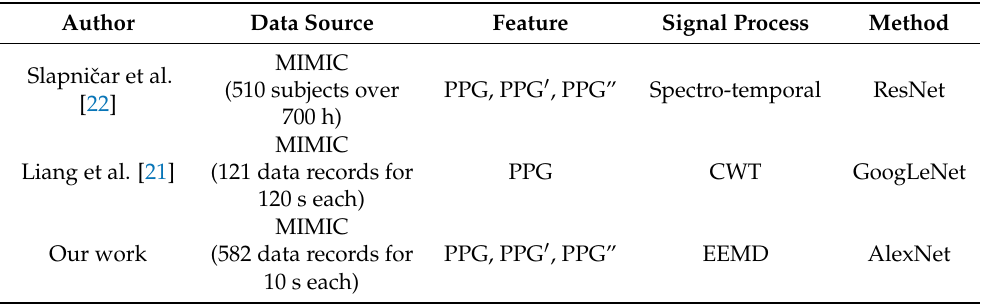
Table 3. Comparison with well-established related work in terms of data source, feature, signal processing, and